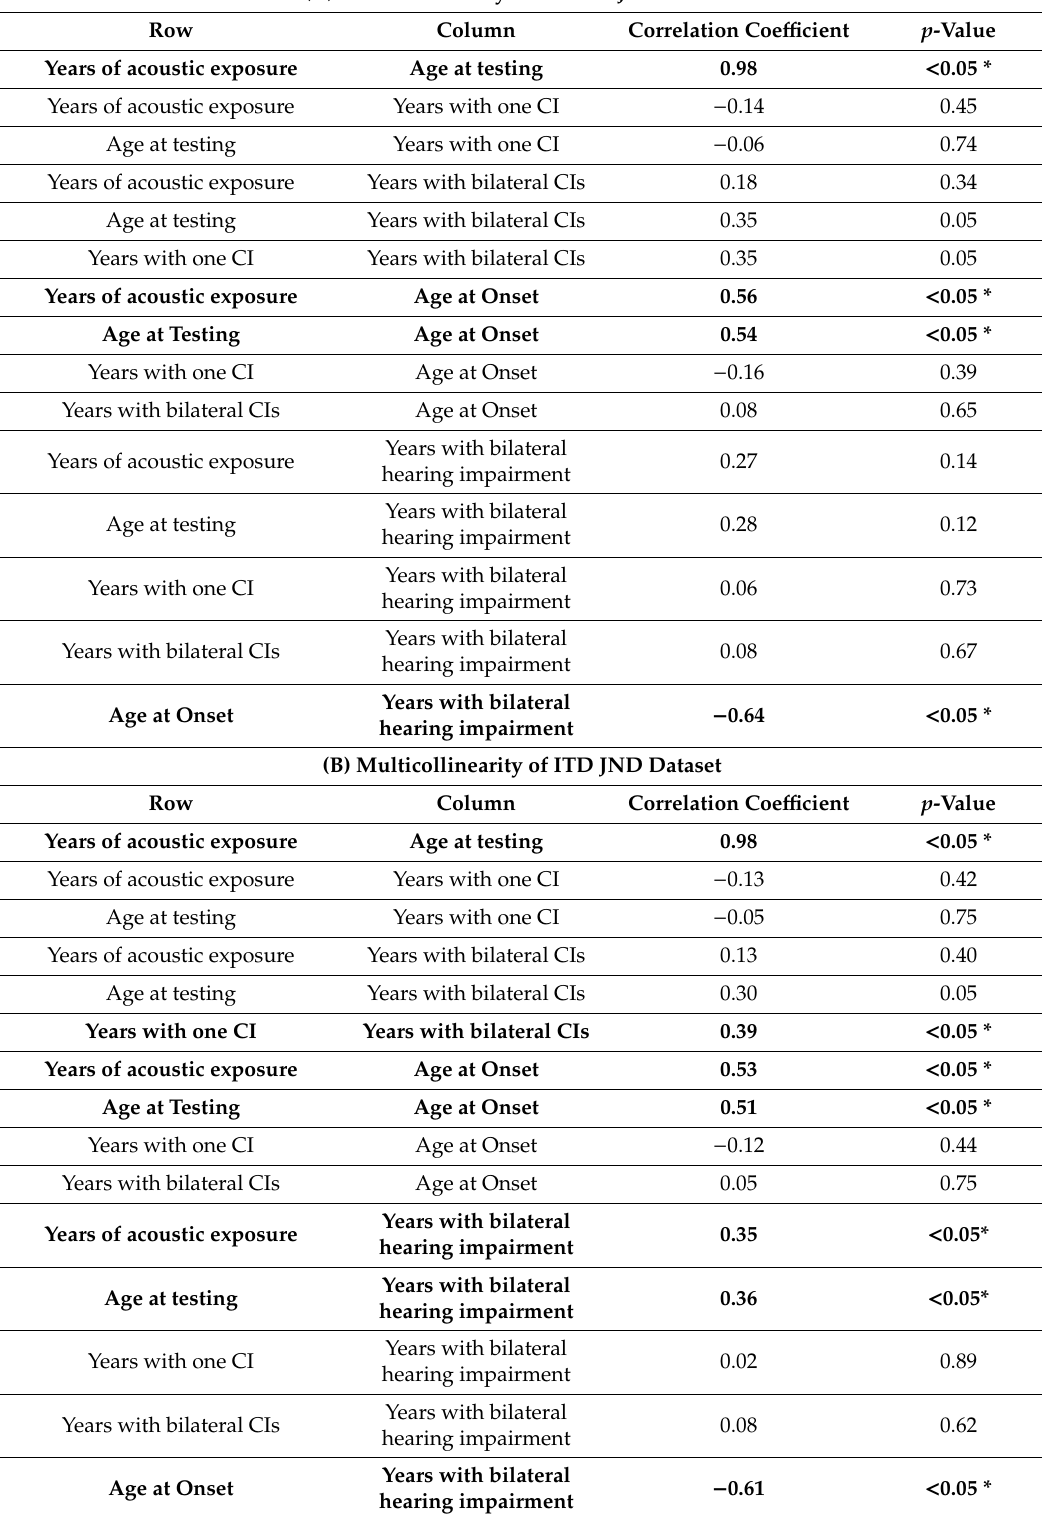
Table 2. ( A ) Pearson correlation coefficients for ILD JND dataset. Correlations with bold text and asterisks represent significant correlations. ( B ) Pearson correlation coefficients for the ITD JND dataset. Correlations with asterisks represent significant